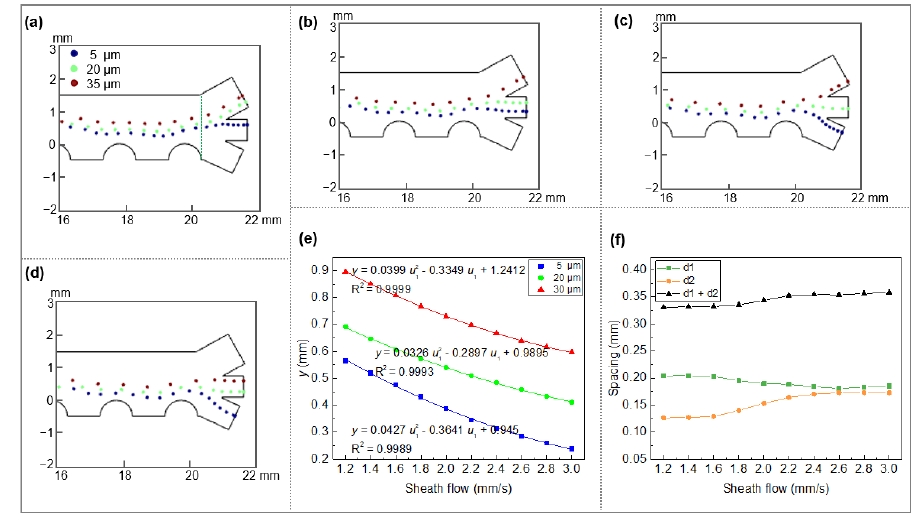
Figure 4. Fractionation of PS particles at different sheath flow ( U 0 = 152 V eff , f = 100 kHz, σ m = 0.001 S/m, u 2 = 1.5 mm/s): u 1 = ( a ) 1.5 mm/s, ( b ) 2 mm/s, ( c ) 2.5 mm/s, ( d ) 3 mm/s; ( e ) variation of particle height over sheath flow rate at x = 20.3 mm; ( f ) particle height spacing of different sizes at different velocity ratios (d1: the spacing between 20- and 35- µ m PS; d2: the distance between 5- and 20- µ m